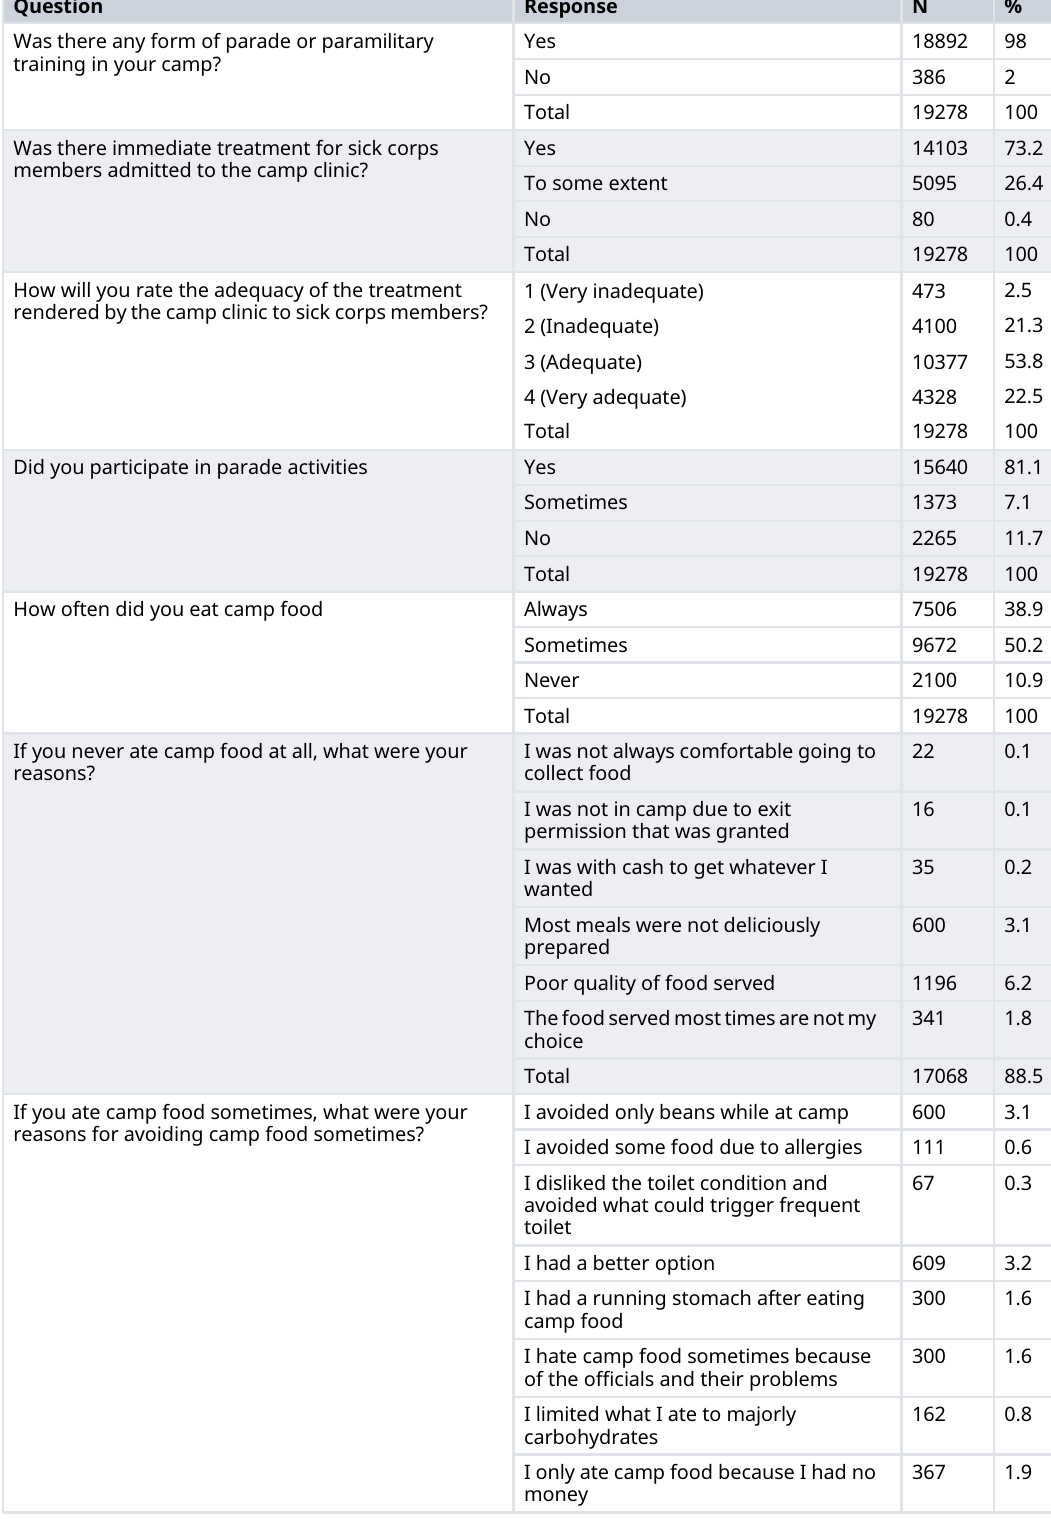
Table 4. Other questions regarding camp experience by corps members. Question